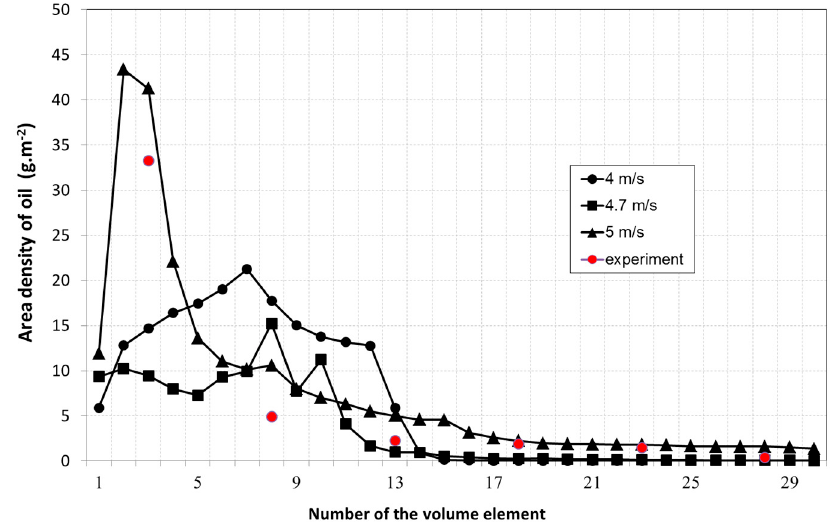
Figure 2. Flow rate of oil density for three different velocities compared to data measured for a 35 mm inner diameter pipe.